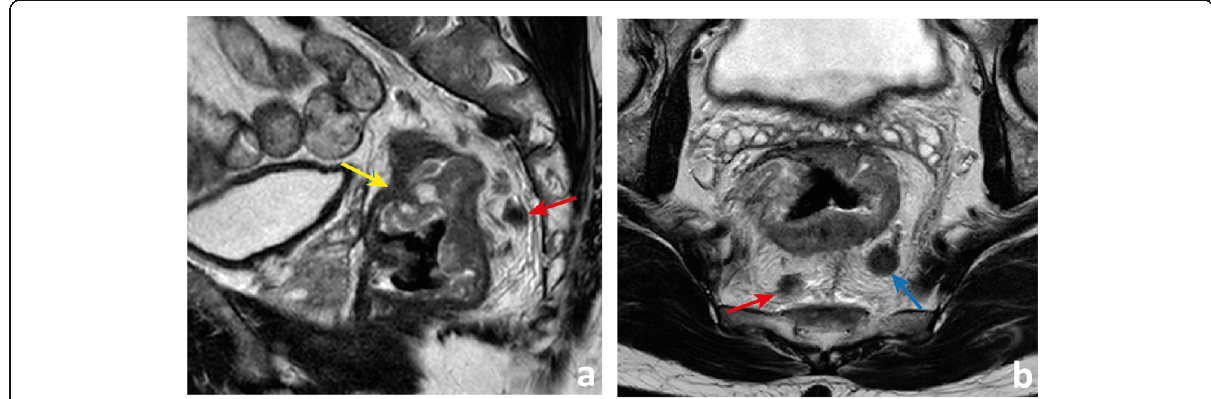
Fig. 16 This patient with a large T3 MRF+ rectal cancer (yellow arrow in a ) presents with a hypointense, highly irregular, intermediate-to-low signal intensity nodule in the mesorectum (red arrows in a and b ) that does not interrupt the course of a vein but is irregular enough for us to admit the possibility of an extranodal deposit (mrENTD). The patient also presented with a round, hypointense slightly heterogeneous and slightly irregularly contoured lesion which we believe to be a lymphadenopathy (blue arrow in b